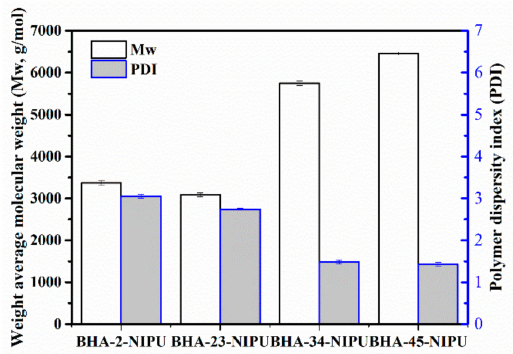
Figure 7. Molecular weight (Mw) and PDI of four NIPU-prepolymers.